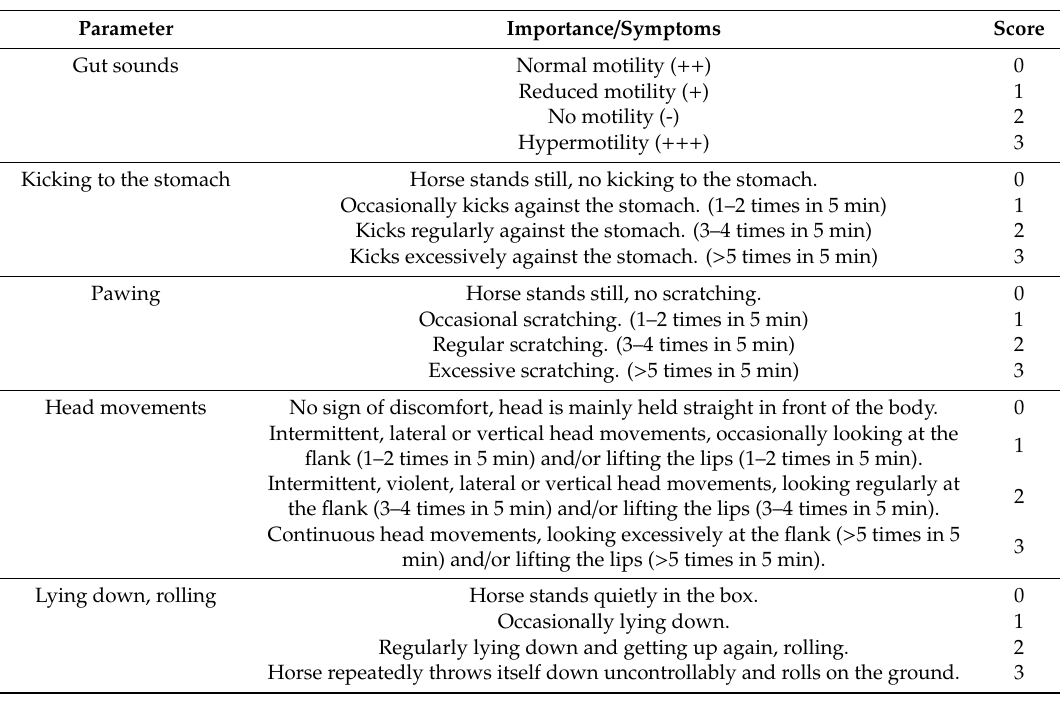
Table 2. Pain scale to determine the intensity of the pain. Additional parameters for horses with